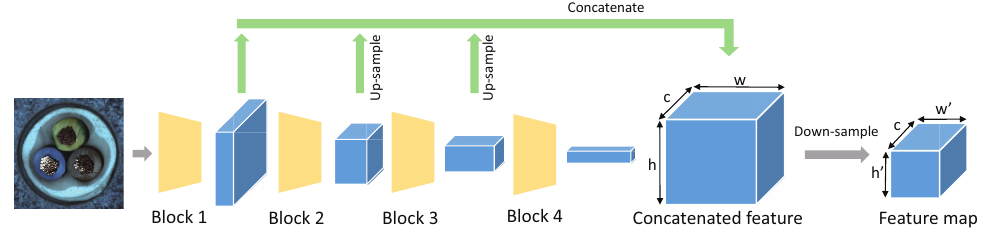
Figure 3. Extracting feature map from WideResnet-50 pretrained on